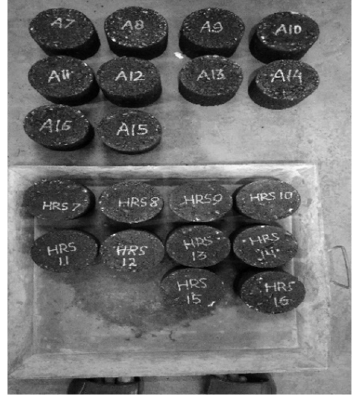
Figure 2. Specimens for the Marshall test.